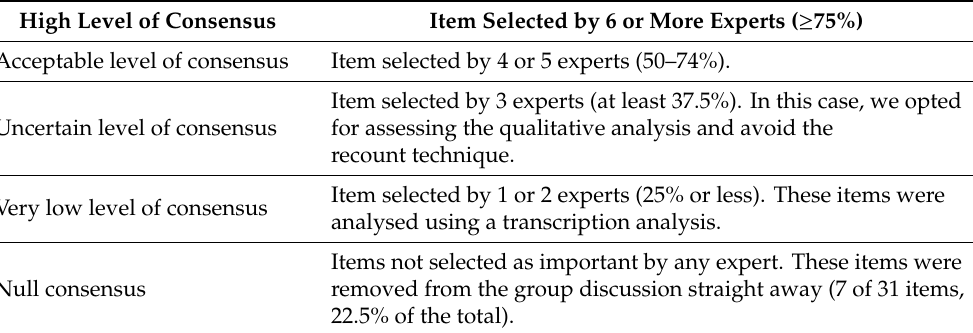
Table 2. Level of consensus among